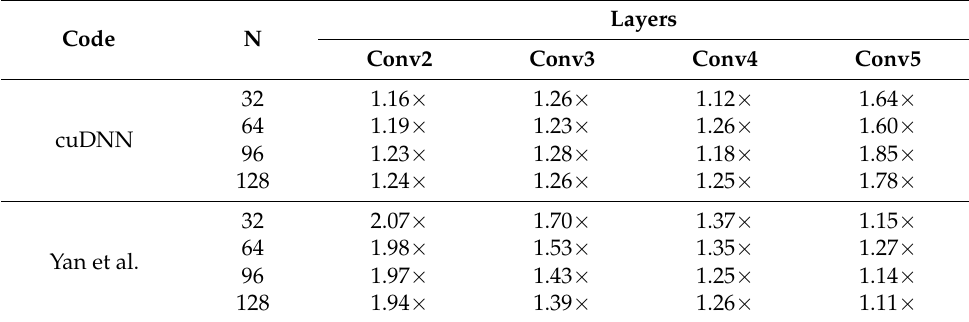
Table 4. SpeedUp. 1.34 × on average over cuDNN and 1.49 × over the [10] CUDA C++ implementa- tion on Ampere RTX 3090.